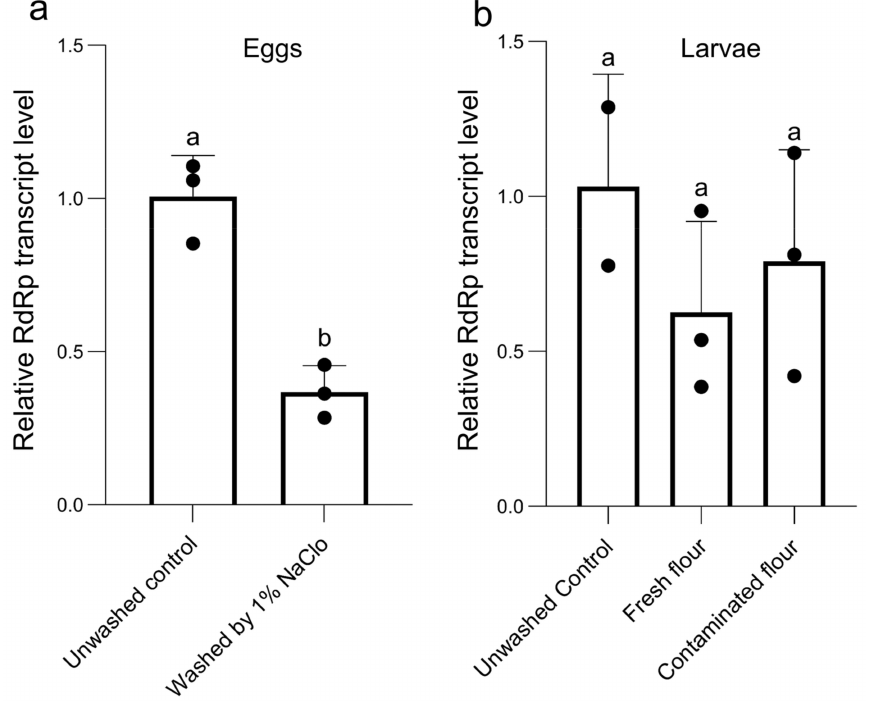
Figure 5. The mRNA levels of RdRp from eggs washed by 1% NaOCl ( a ) the larvae hatched from those eggs in fresh or contaminated flour ( b ). Data were normalized using the 2 − ∆∆ Ct method. The bars represent the mean of three replications (each data point represents one replication) and the standard deviation of each bar is shown for n =